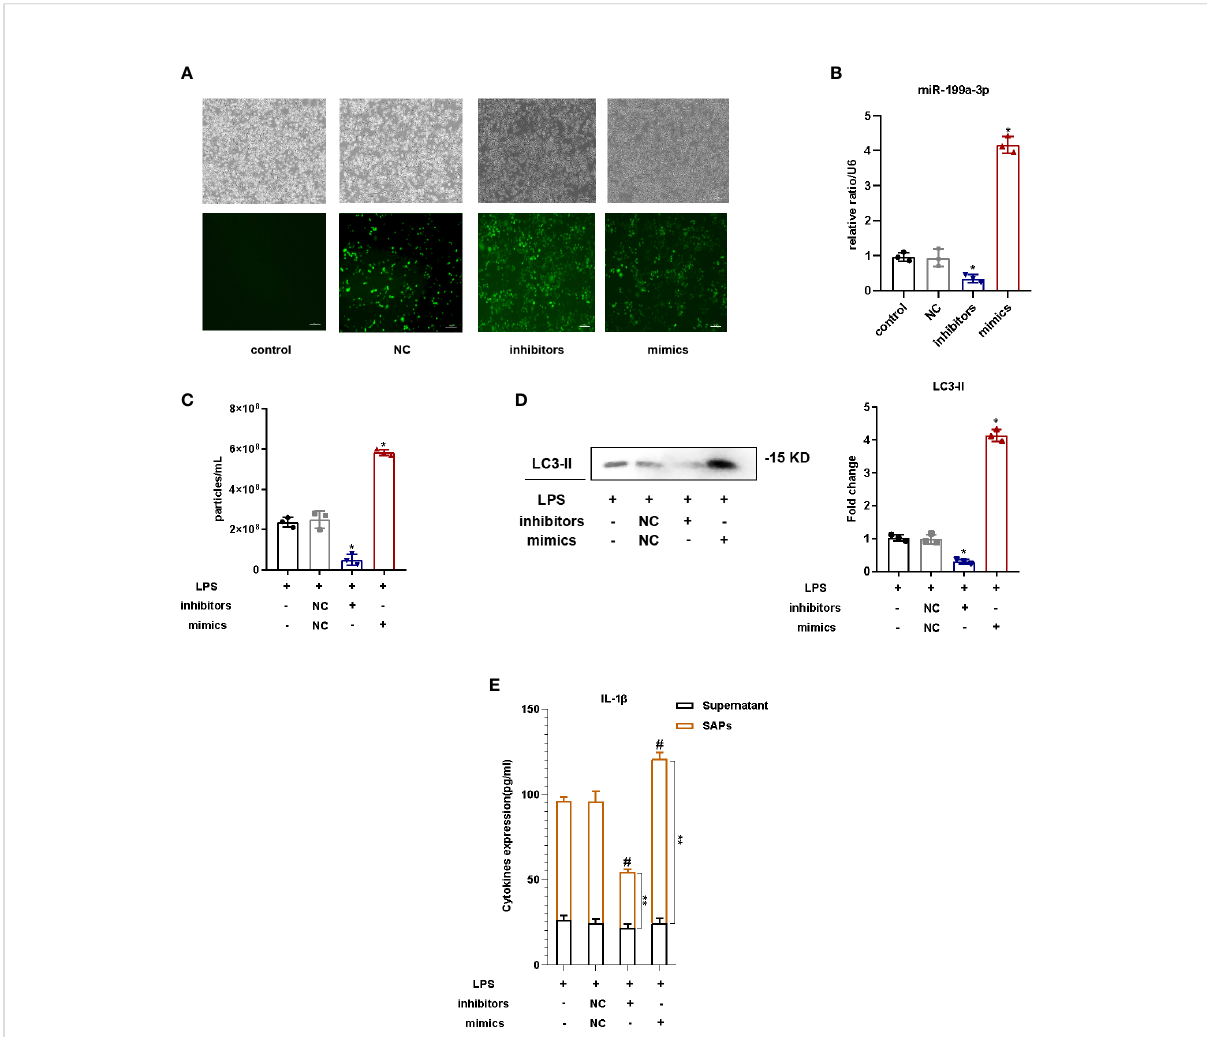
FIGURE 4 MiR-199a-3p overexpression stimulated SAP secretion in LPS-induced macrophages. Before LPS treatment, RAW264.7 cells were transfected with MiR-199a-3p mimics or inhibitors. (A) The ef fi cacy of transfection was detected by fl uorescence microscopy. (B) MiR-199a-3p levels were examined after 24 h of transfection using qRT-PCR. (C) Nanoparticle tracking analysis revealed signi fi cant increases in the levels of vesicles from LPS-stimulated RAW264.7 cells in the MiR-199a-3p mimics groups compared with those in the control groups. (D) Western blotting analysis demonstrated that there were signi fi cant increases in the levels of LC3-II in vesicles from LPS-stimulated RAW264.7 cells in the MiR-199a-3p mimics groups compared with those in the control groups. (E) IL-1 b levels in SAPs and cell-culture supernatant were assessed via ELISA after the SAPs were lysed using Triton X-100. The experiments were repeated at least three times (n = 3 per group). Each value represents the mean ± SD of three independent experiments. *p < 0.05 vs . NC group; #p < 0.05 vs . the SAPs + supernatant in the NC group; **p < 0.05 vs . the SAPs in the NC group, one-way